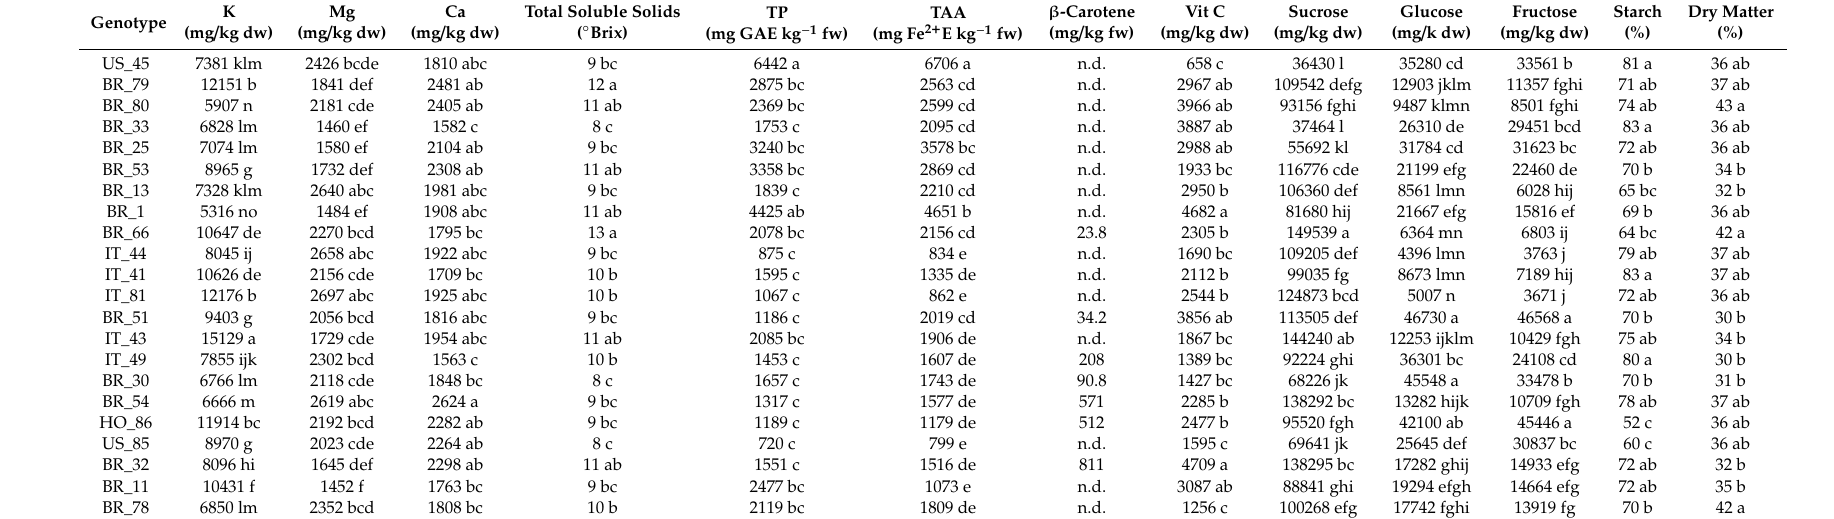
Table 4. Qualitative measurements performed on the sweet potato